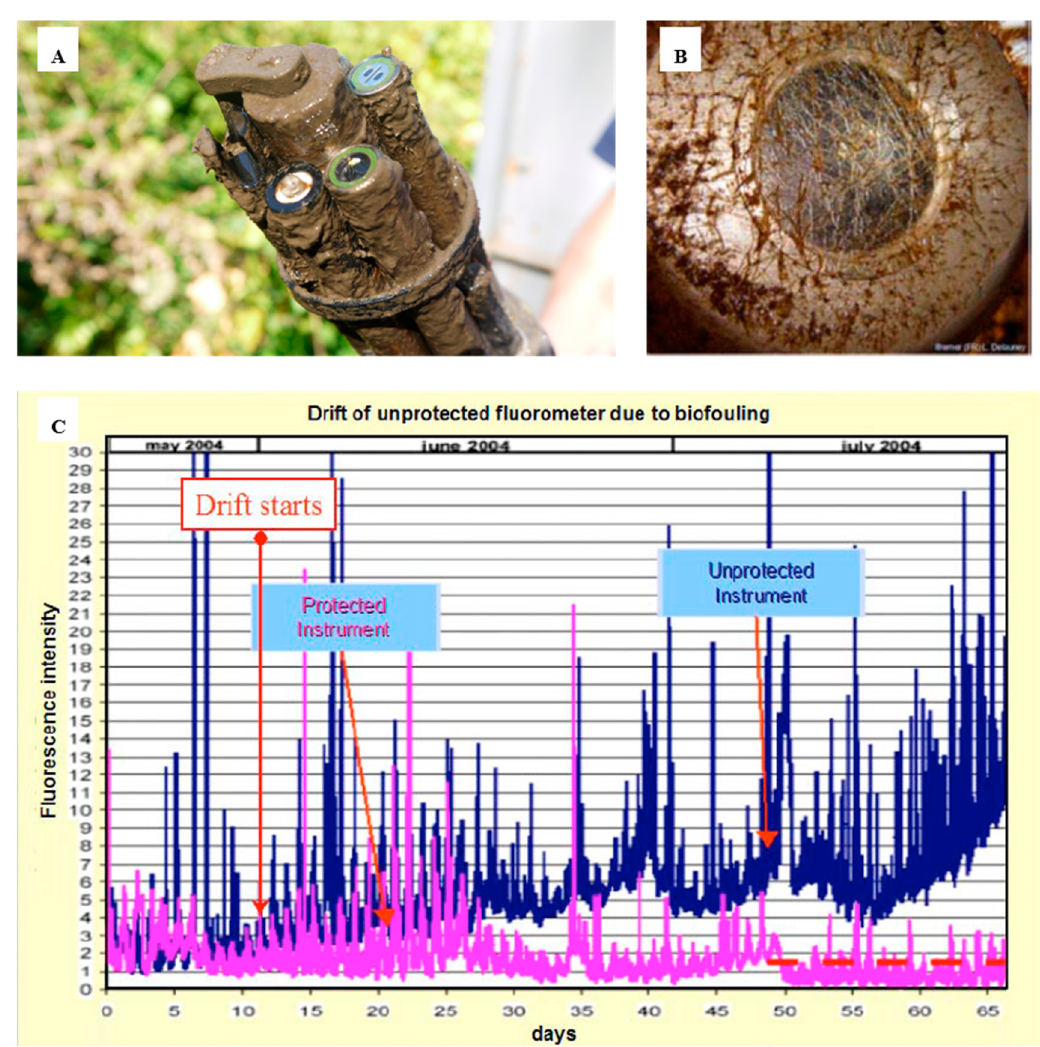
Figure 2. Overview of the biofouling on optical sensors and how this affects measurements over time. ( A ) EXO-sonde after it had been deployed (reproduced with permission of © 2020 YSI, a Xylem brand [38]); ( B ) transmissometer after 30–39 days in Throndheim harbour (Norway) during summer [11]; ( C ) drift of an unprotected fluorometer due to biofouling development on the optics [11] (© L. Delauney et al., 2010. This work is distributed under the Creative Commons Attribution 3.0 License).